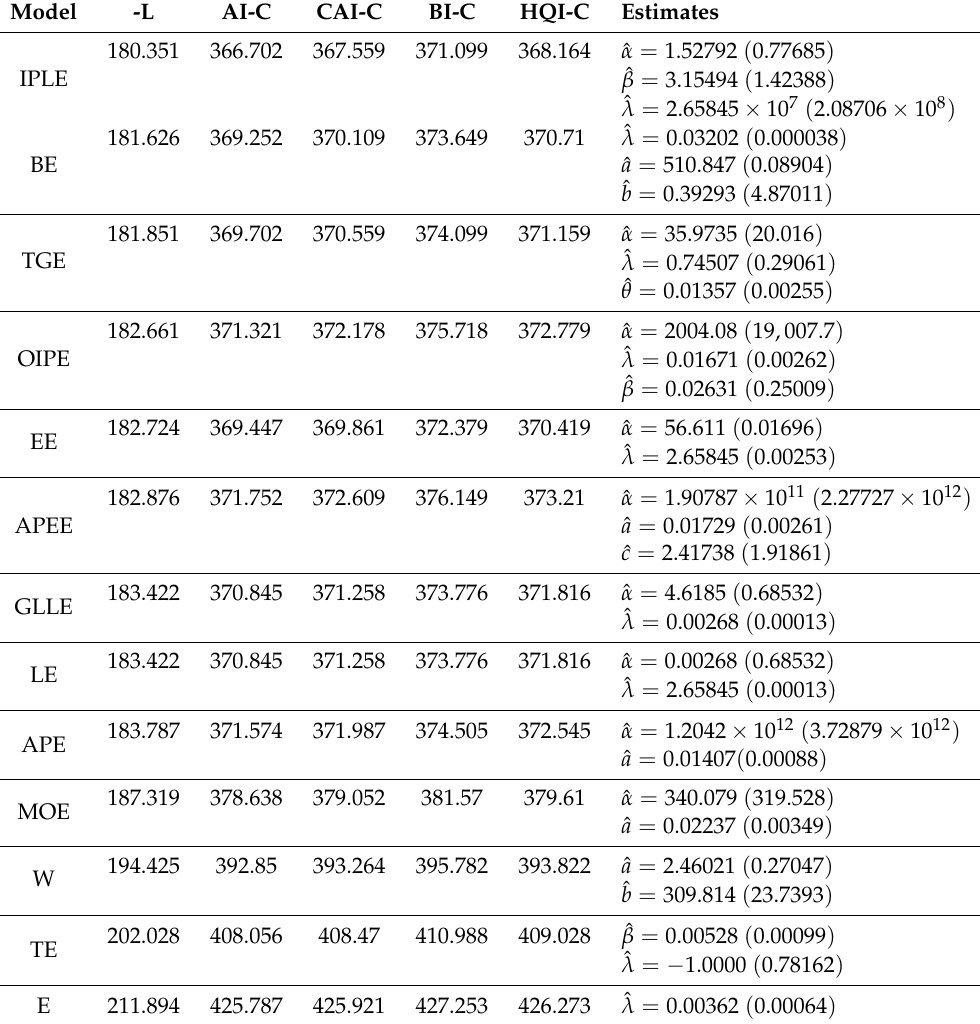
Table 6. Discrimination measures of the IPLE model and other fitted models. CAI-C, consistent Akaike information criterion; BI-C, Bayesian information criterion; HQI-C, Hannan–Quinn information criterion; BE, beta exponential; TGE, transmuted generalized exponential; OIPE, odd inverse Pareto exponential; GLLE, generalized odd log-logistic exponential; APEE, alpha power exponentiated exponential; MOE, Marshall–Olkin exponential; TE, transmuted exponential.